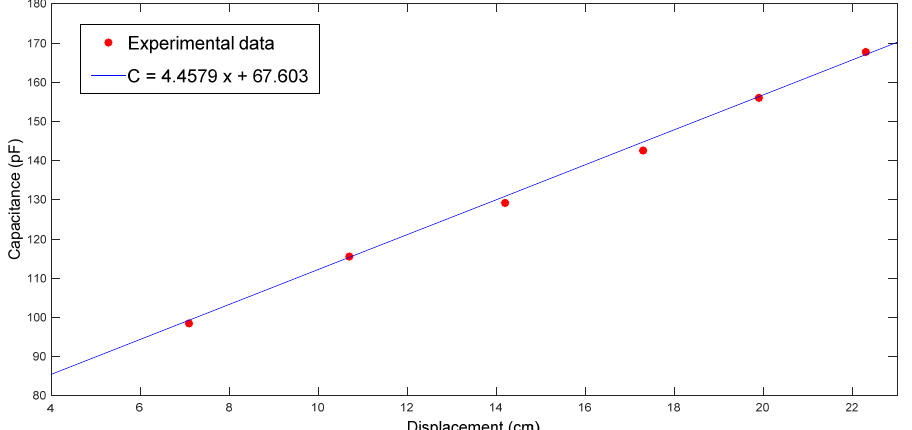
Figure 16. Relationship between flow front displacement and capacitance in the first RTM experiment using a seven-layer fiber preform .